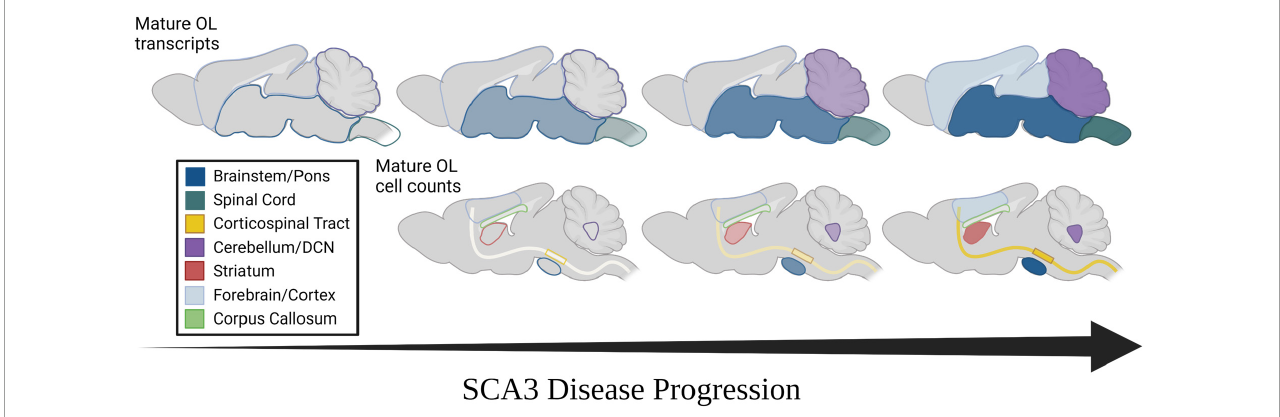
FIGURE5 Spatiotemporal progression of mature oligodendrocyte transcript dysregulation and cell count reduction in mouse models of SCA3. (Top) Temporal progression of regional transcriptional downregulation of mature oligodendrocyte markers as observed in mouse models. (Bottom) Temporal reduction of regional mature oligodendrocyte cell counts as observed in mouse models. Horizontal arrow represents disease progression over time. Transparency and shade of regional colors represent magnitude of oligodendrocyte maturation impairments (darker/less transparent = more affected, lighter/more transparent = less